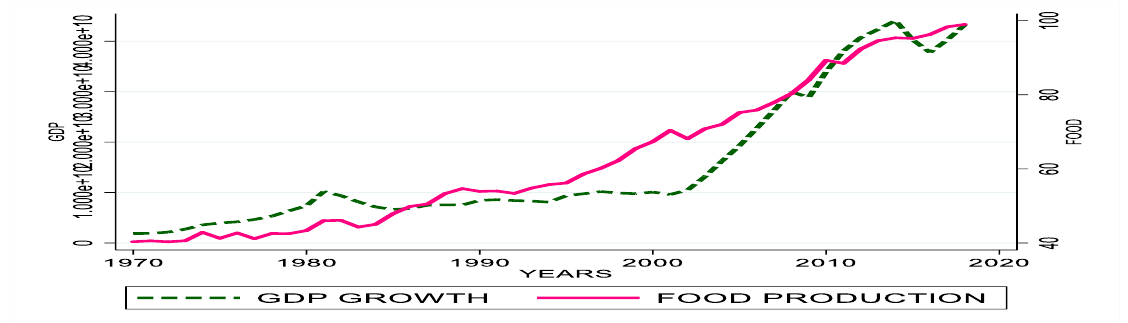
Figure 1: Evolution of Gdp Growth Versus Cereal Production Growth in Ss Africa. Figure 1: This Figure Presents Parfait Co-Movements Between Gdp and Cereal Production and Justifies The Part That Cereal Production Takes in The Entire African Gdp Growth (Suri & Udry, 2022).